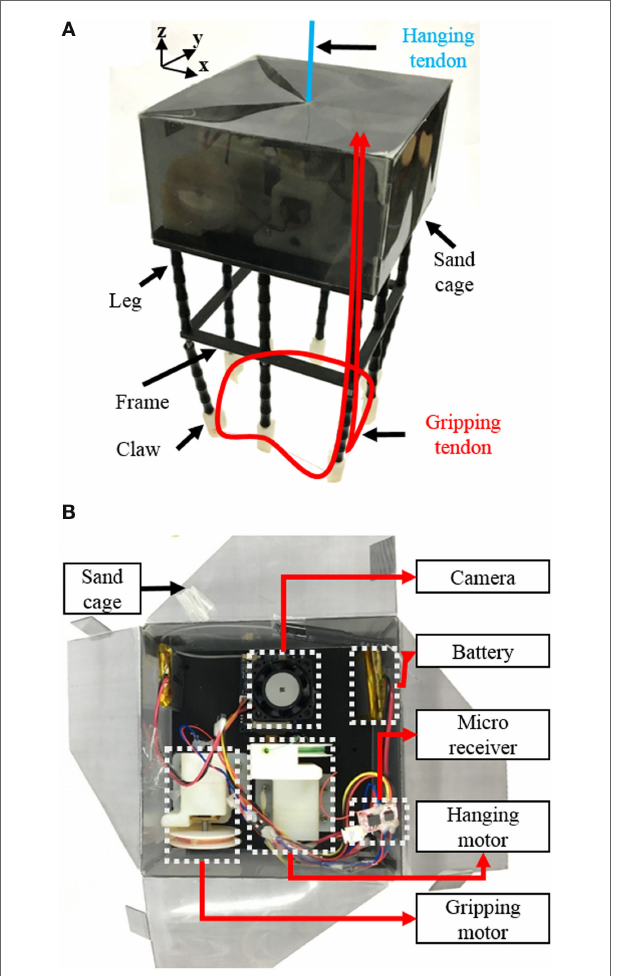
FigUre 6 | adaptive caging gripper and its electronic components . (a) Appearance of the adaptive caging gripper. The hanging tendon, which moves grippers in the z -axis direction, is denoted by a blue line, and the gripping tendon path is denoted by a red line. (B) Electronic components of the gripper. The origami cage contains two DC motors, two batteries, one camera, and a micro